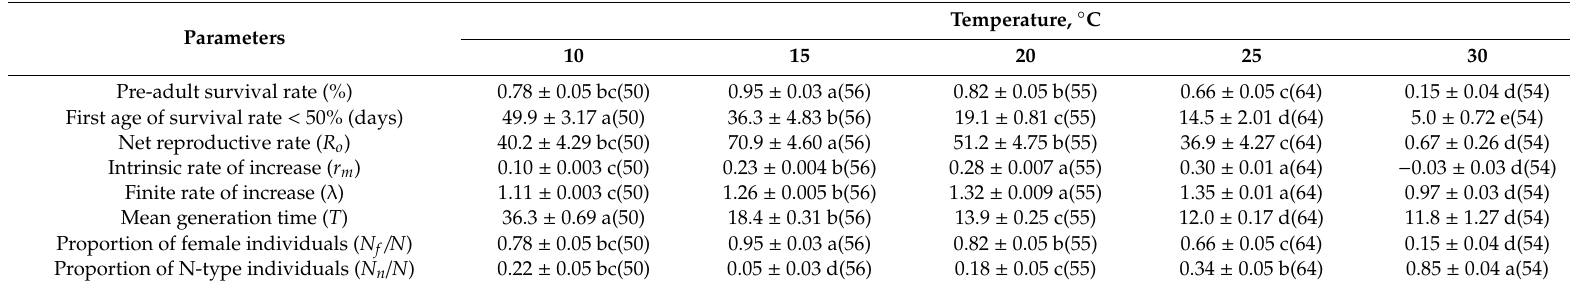
Means in the same row followed by di ff erent letters are significantly di ff erent ( p < 0.05), as determined by the paired bootstrap test. Numbers in parentheses indicate the number of survivors of A. pisum per life stage at each